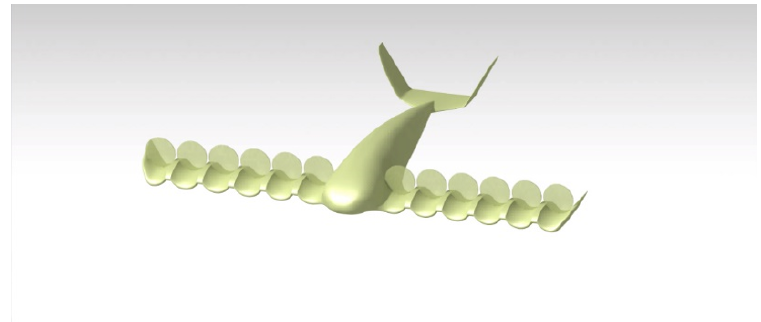
Figure 1. A model of the multi-propeller channel wing UAV.